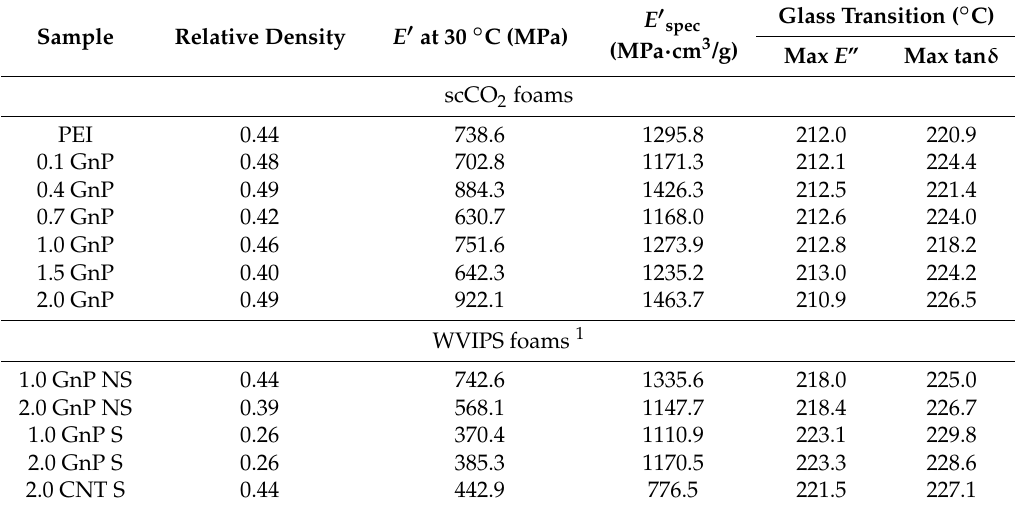
Table 4. DMTA results of pure PEI and PEI-GnP nanocomposite